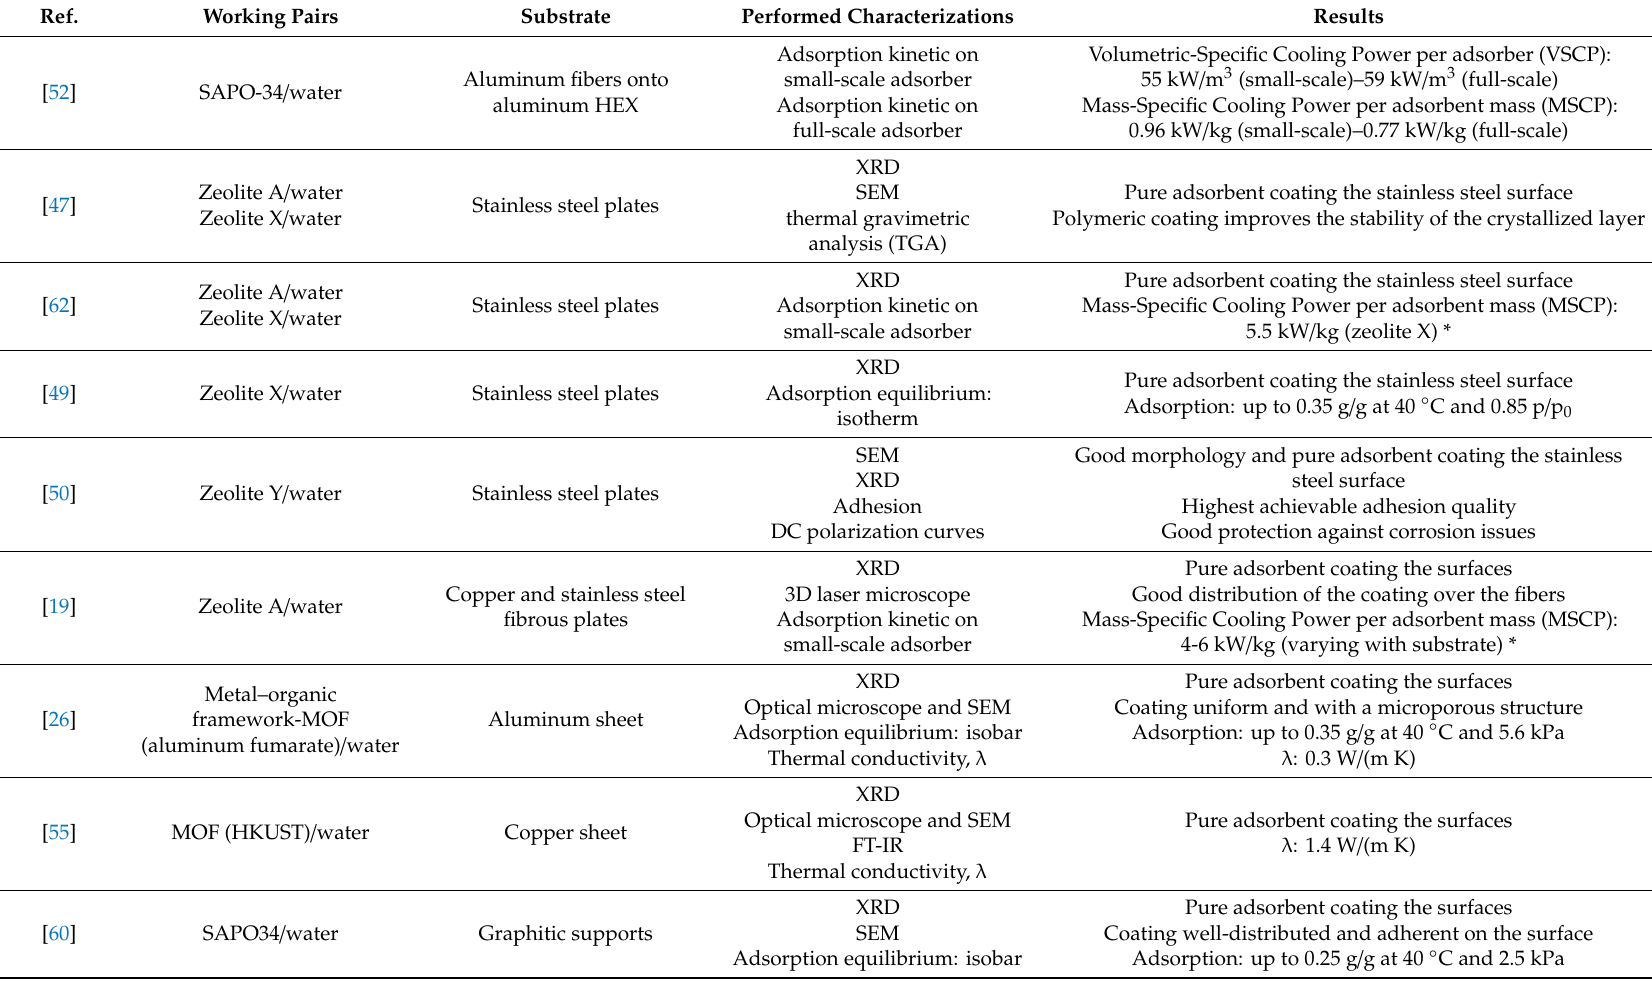
Table 2. Comparison table of the main features of in situ crystallized coating for heat pump application.